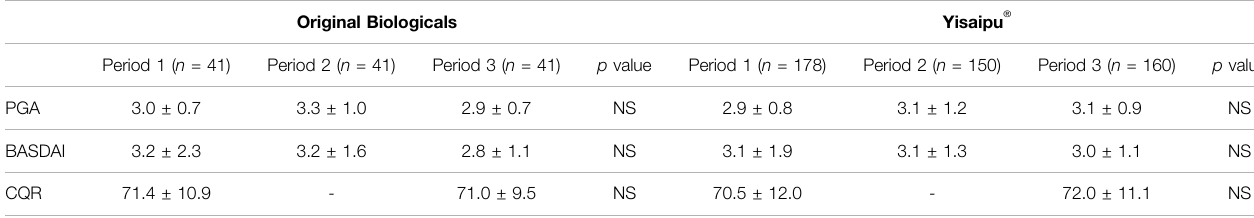
TABLE 5 | Disease activity through COVID-19 epidemic. Original